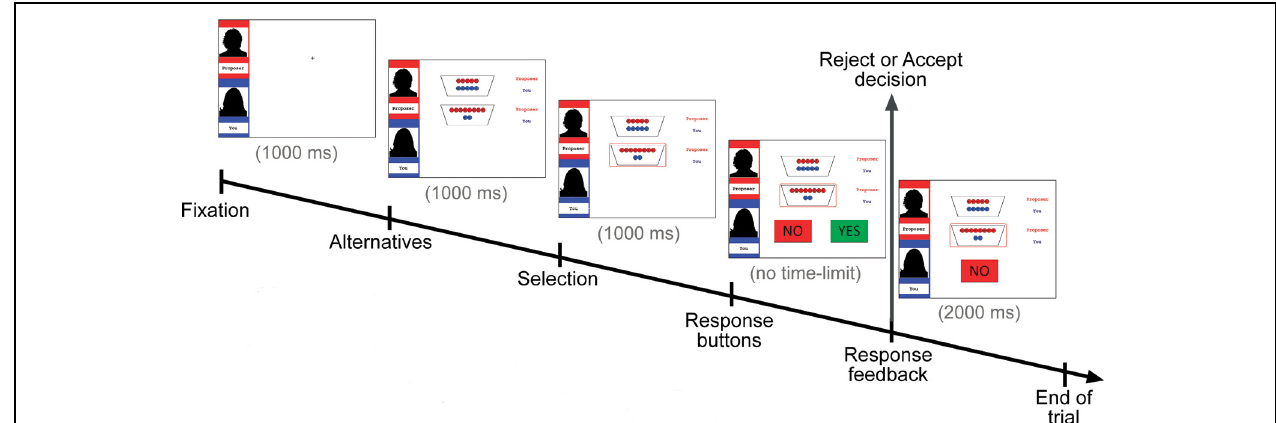
FIGURE 1 | Display of a trial in the intentional fair-alternative condition. The name of the proposer is shown at the top (here “Proposer”) and the name of the participant is shown underneath (here “You”). The two potential distributions are specified by red and blue coins (red for proposer, blue for responder), with the offer selected by the proposer encircled in red.